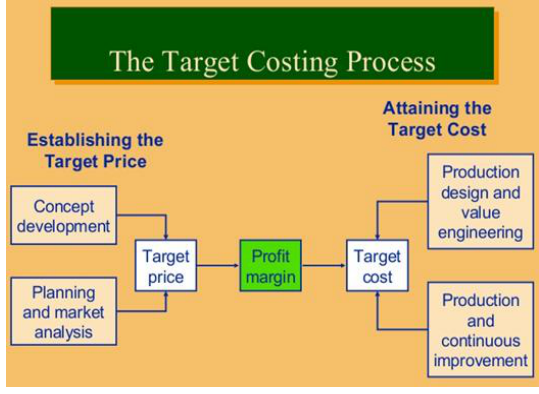
Table 1: Laboratory Department